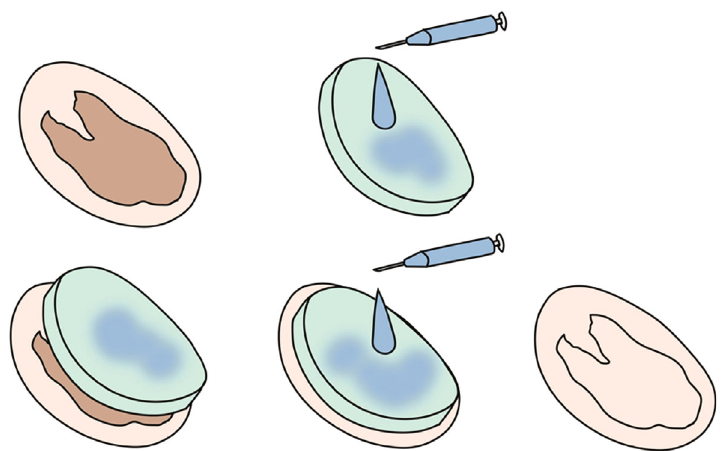
Figure 3: Diagram of EGF or FGF2 in repair of chronic perforation.